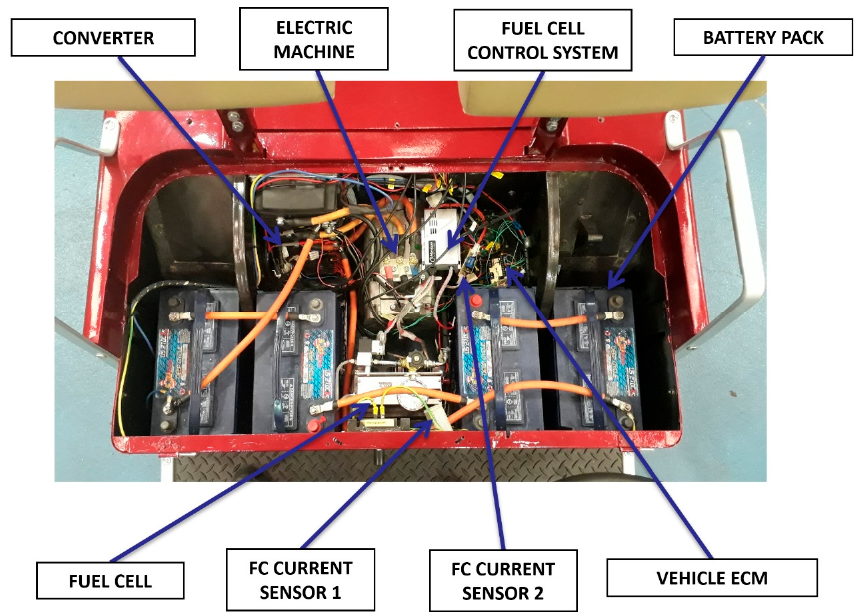
Figure 22. Fuel Cell Extend Range Electric Golf Car.